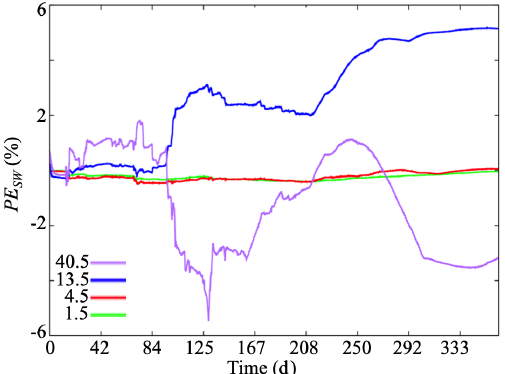
Figure 8. Temporal variations of the percent error of surface water storage (PE SW ) obtained with meteorological forcing at spatial res- olutions of 1.5, 4.5, 13.5, and 40.5km with respect to the highest spatial resolution of meteorological forcing